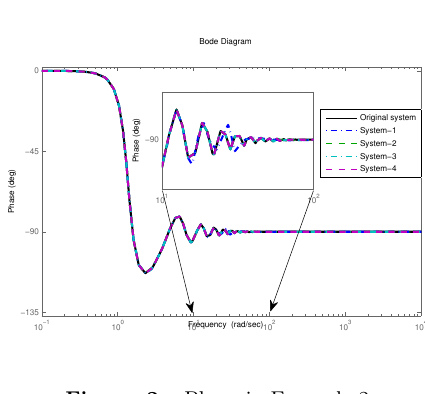
Figure 2. Phase in Example